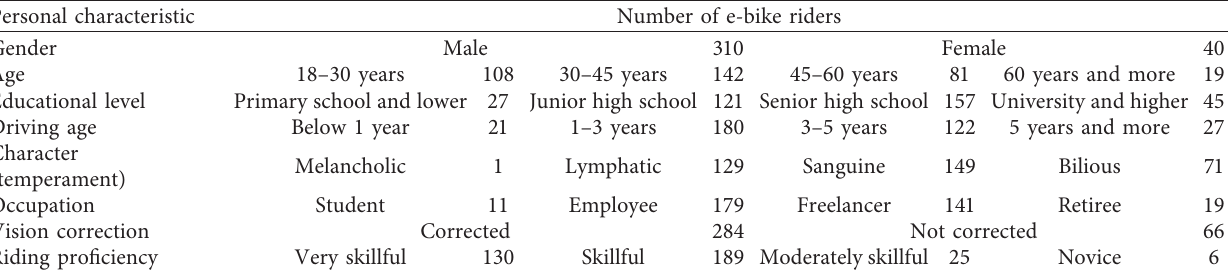
Table 3: Statistics of personal characteristics of e-bike riders.